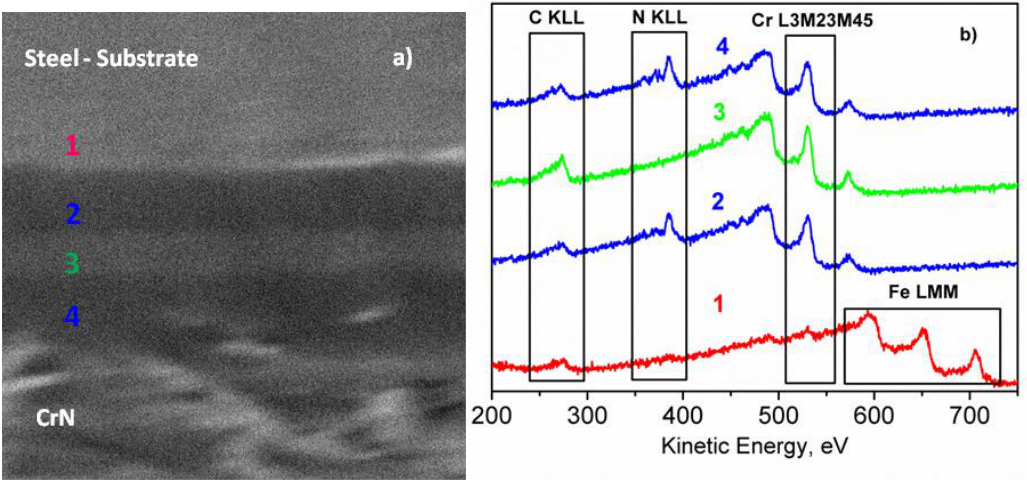
Figure 11. SEM image ( a ) and AES spectra ( b ) acquired along the cross section of the multilayer coating [23].